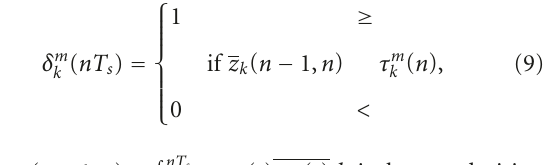
Figure 3: Detector structure at the k th mobile node for the decision making based on the observations during time interval (( n − 1) T s , nT s ]. respectively, where (cid:6) E k ( x 0 , y 0 ; n − 1, n ) = y 0 ) m k ( t ) dt and E m function is defined as Q ( x ) = 1 /